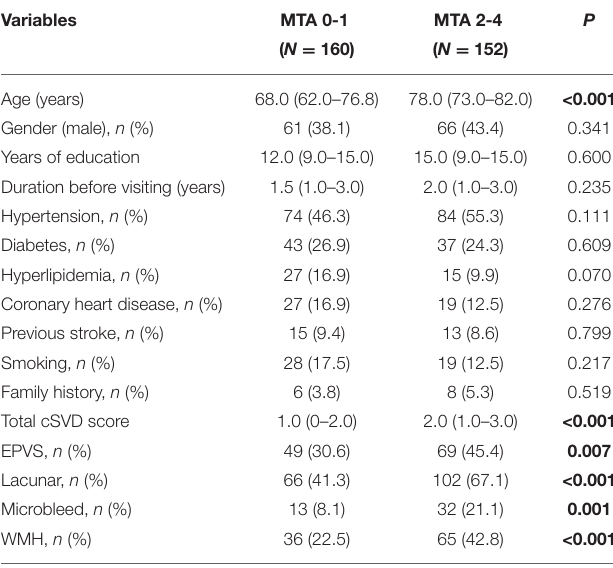
TABLE 1 | Demographic, clinical, and cSVD characteristics of patients in different MTA groups.